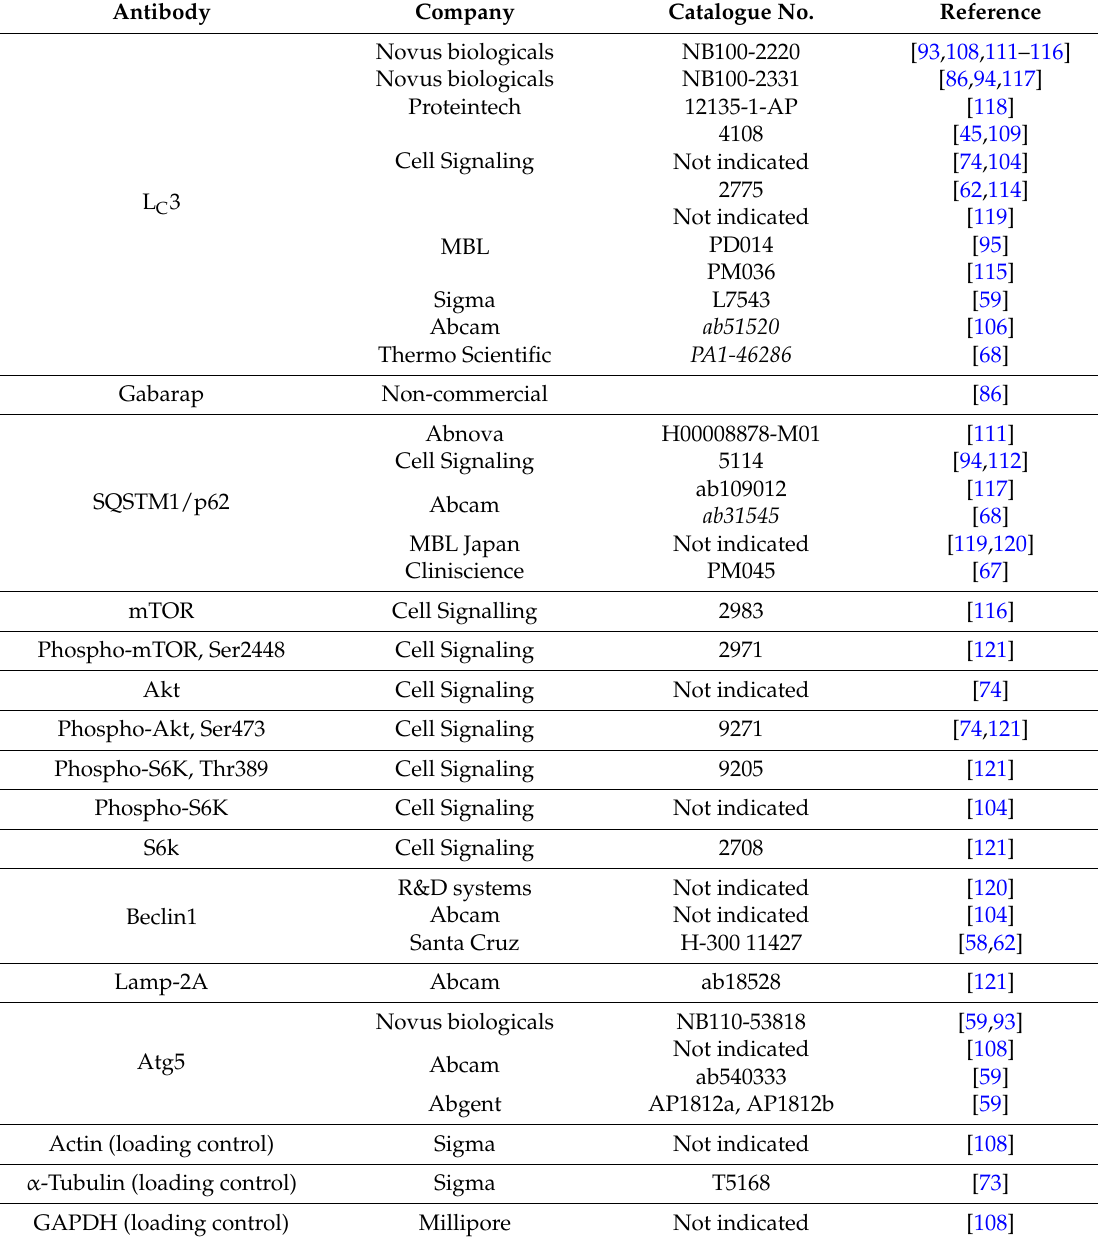
Table 3. List of antibodies ever used to detect autophagy-related proteins in zebrafish. (Catalogue numbers listed in italics have been used for immunostaining